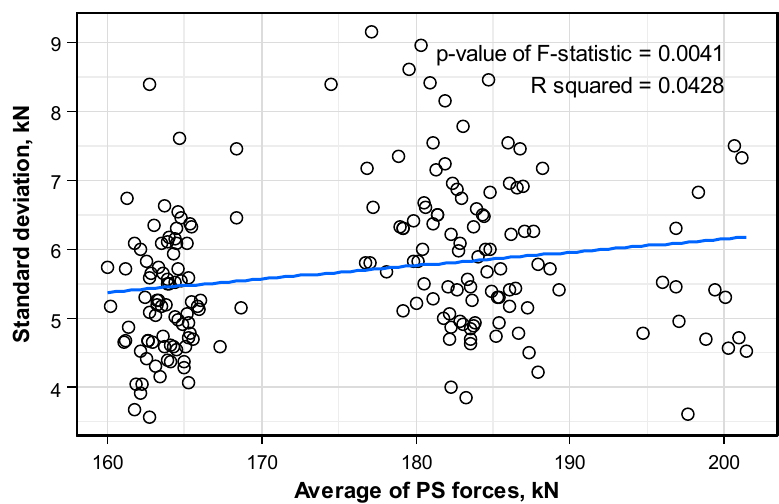
Figure 14. Distribution pattern of the standard deviation of the prestress force per anchor head according to the mean prestress force.